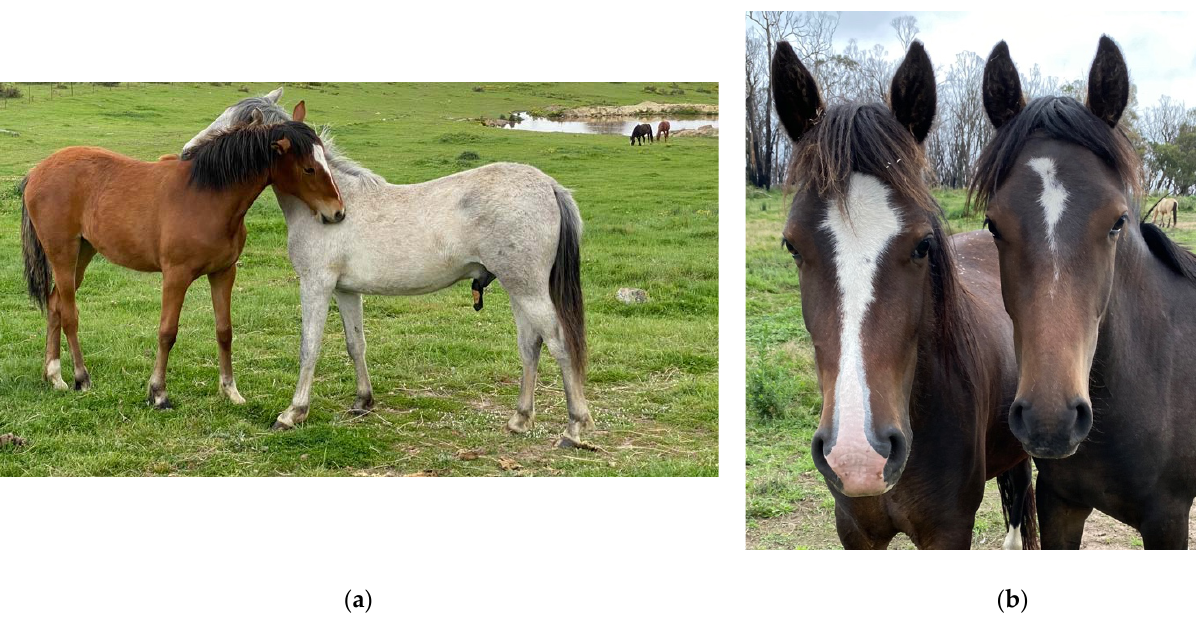
Figure 12. Affiliative behaviours ( a ) Allogrooming between two older foals, ( b ) Close spatial proximity between a mare and her 2-year-old filly. Images A. M. Harvey.